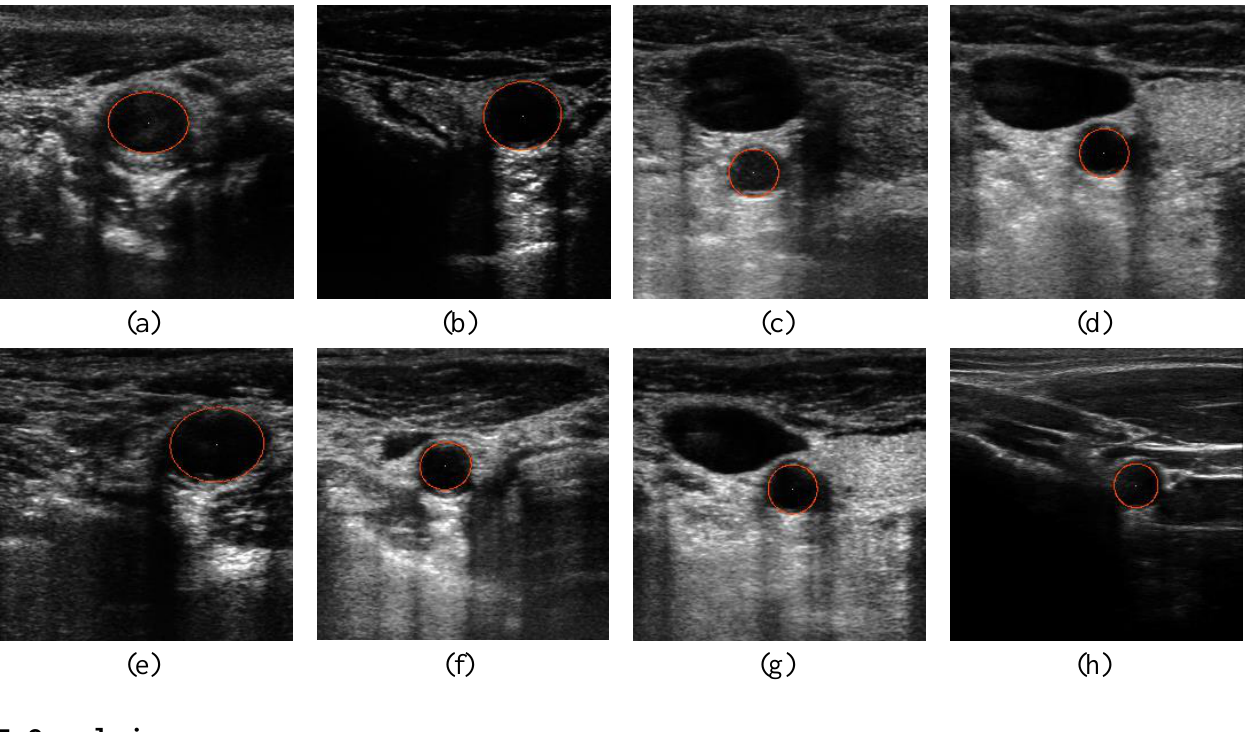
Figure 13. Some results obtained with the proposed method in different